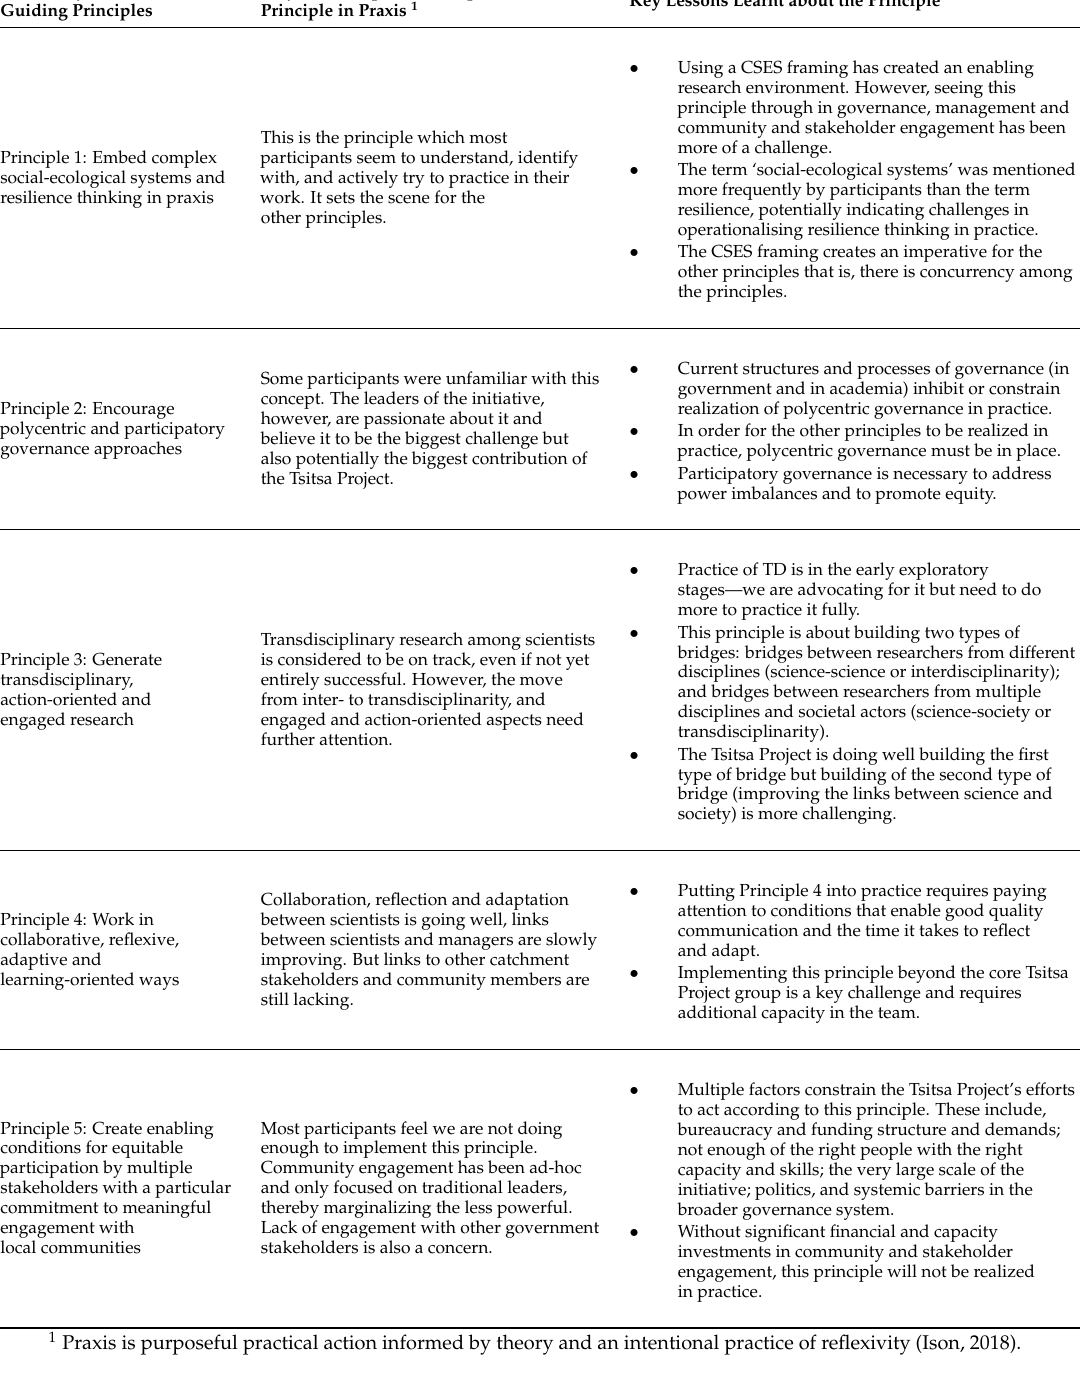
Table 1. Lessons learnt about putting the Tsitsa Project principles into